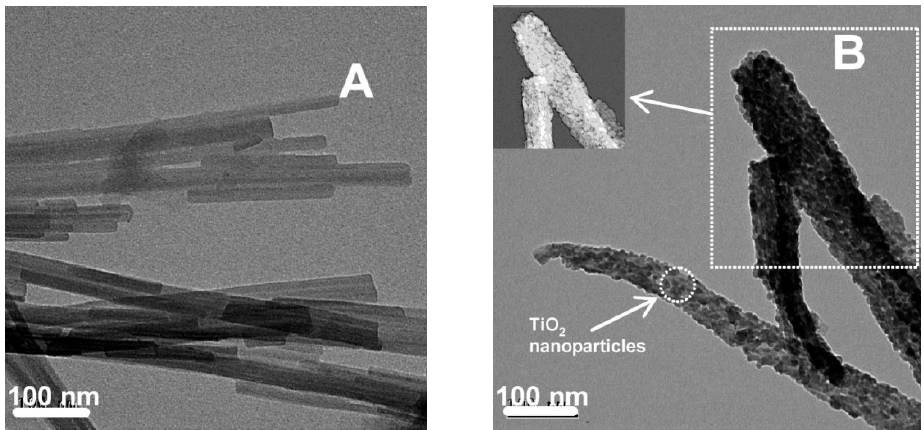
Figure 13. TEM images of: ( A ) cetyltrimethylammonium-exchanged sepiolite; ( B ) S-doped TiO 2 /sepiolite nanocomposite. Adapted with permission from ref. [202]. Copyright 2008 American Chemical Society.